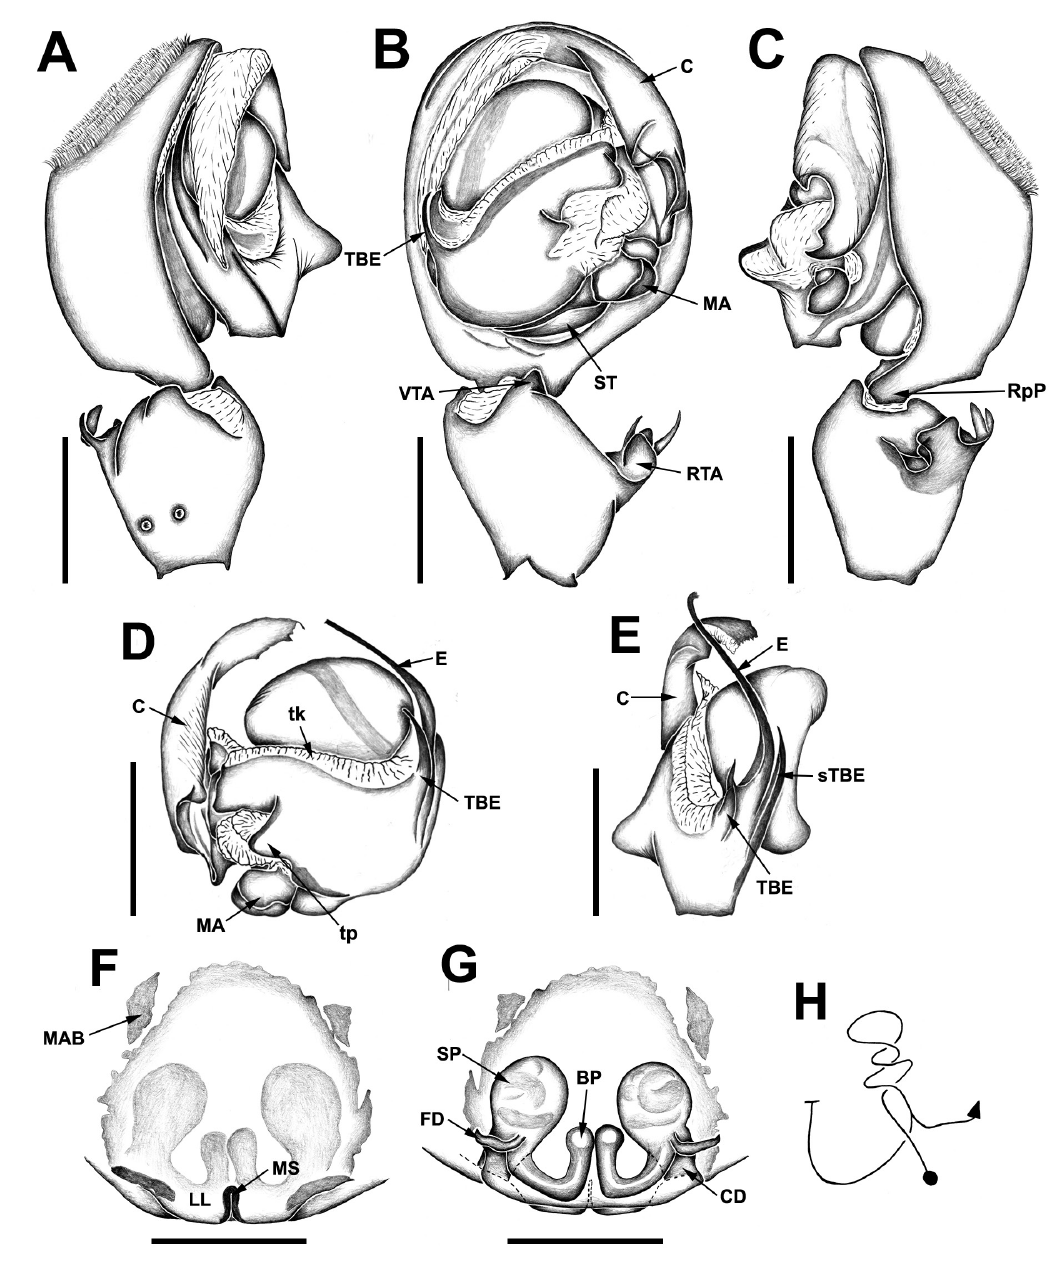
Fig. 5. Cuiambuca aratangi sp. nov. A − E . Holotype, ♂ (IBSP 167826). F − H . Paratype, ♀ (IBSP 8907). A . Left palp, prolateral view. B . Left palp, ventral view. C . Left palp, retrolateral view. D . Right palp, bulb, ventral view. E . Right palp, detail of embolus base, prolateral view. F . Epigyne, dorsal view. G . Vulva, ventral view. H . Schematic course of internal duct system. Abbreviations: BP = blind ending projection; C = conductor; CD = copulatory duct; FD = fertilization duct; LL = lateral lobe; MA = median apophysis; MAB = muscle attachment bands; MS = median septum; RpP = retroproximal cymbial projection; RTA = retrolateral tibial projection; SP = spermathecae; ST = subtegulum; sTBE = secondary tegular projection close to embolus base; TBE = tegular projection close to embolus base; tk = tegular keel; tp = tegular protrusion; VTA = ventral tibial projection. Scale bars = 0.5